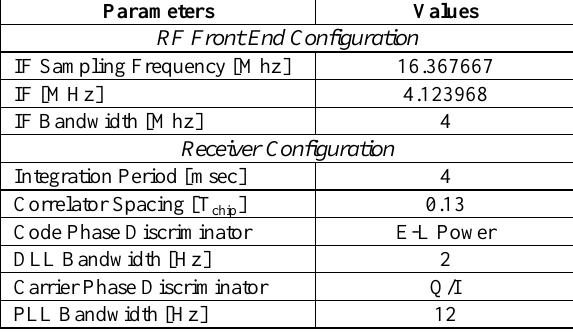
Table 1. RF Front-End and Receiver Configuration